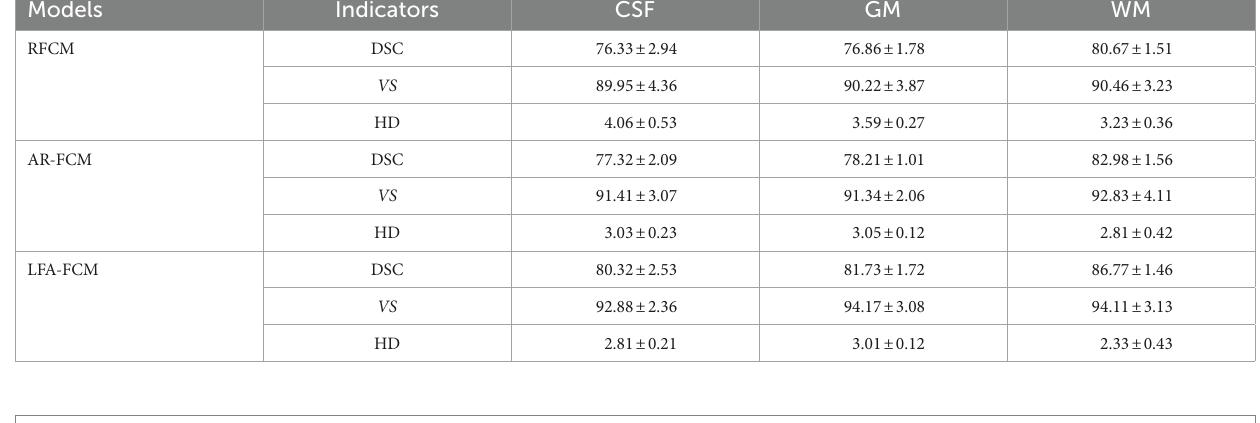
TABLE 5 Average DSC, VS and HD values for RFCM, AR-FCM and LFA-FCM. Models